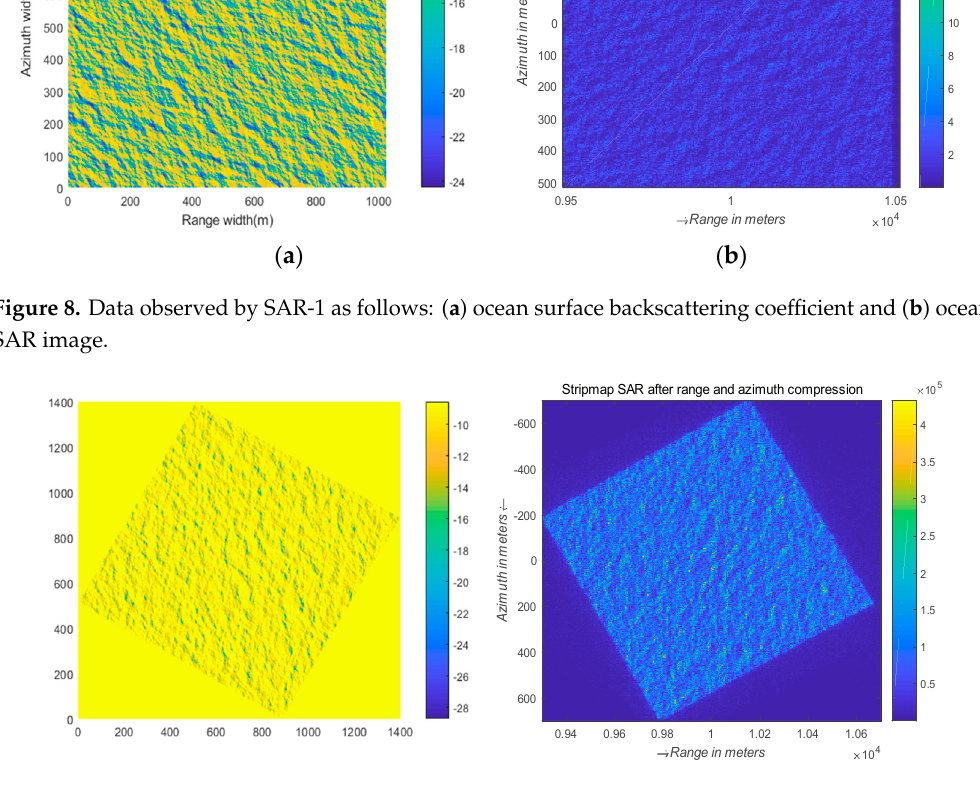
Figure 9. Data observed by SAR-2 as follows: ( a ) ocean surface backscattering coefficient and ( b ) ocean SAR image.